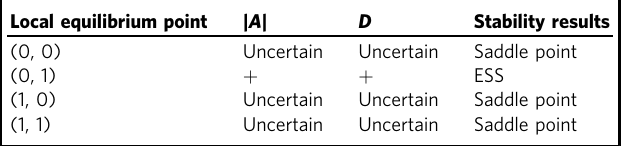
Table 4 System evolutionary stability analysis in Situation (2).